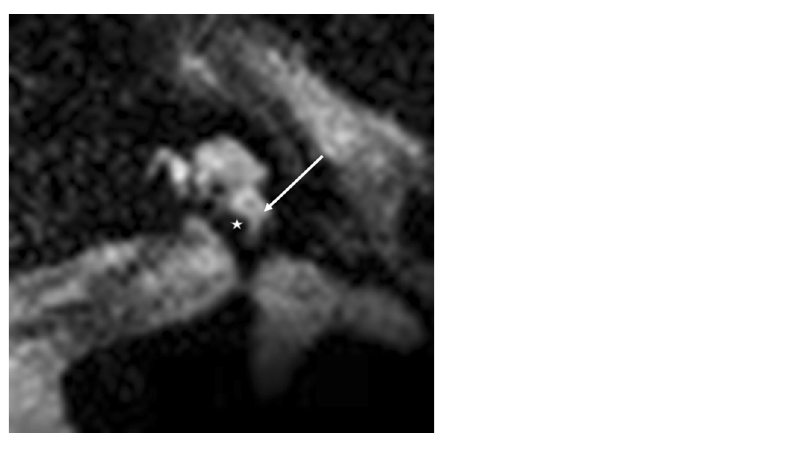
Figure 4. Modiolar electrode, first turn, HFMS ST Position. Star represents diminishing electrode signal, arrow represents basilar membrane.